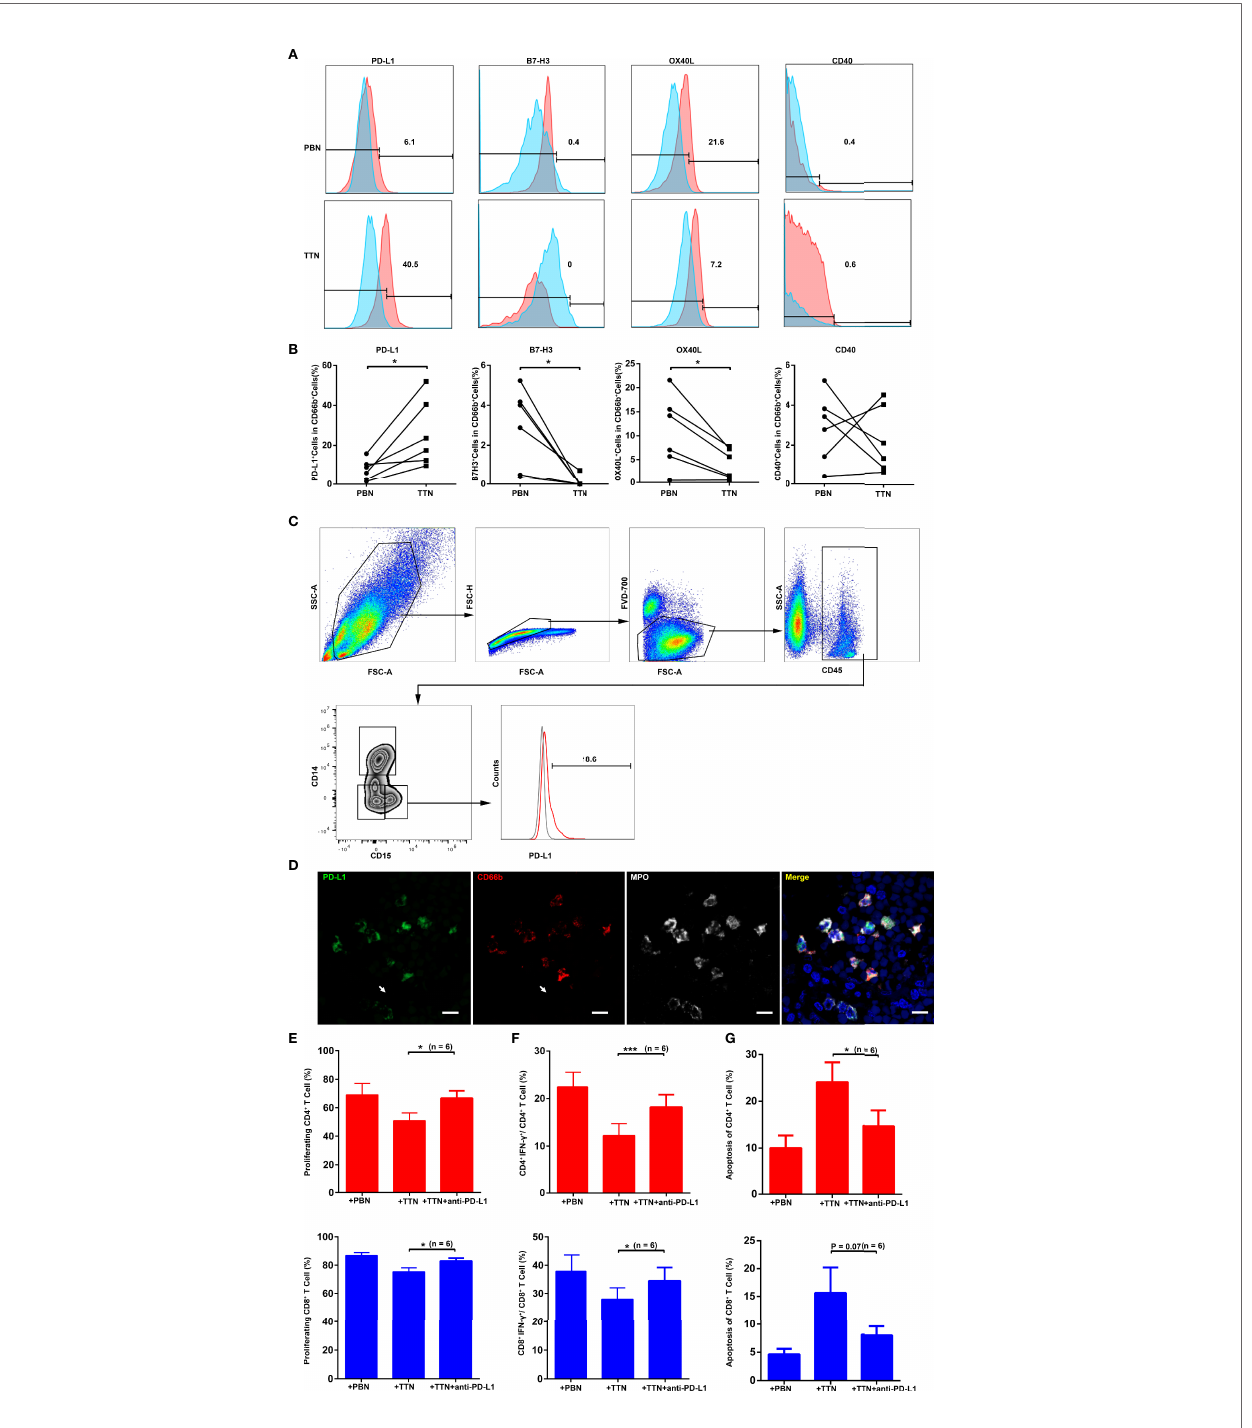
FIGURE 4 | The expression of PD-L1 on TTN and its role in the suppression of T cell immunity. (A) The expression of co-suppressive molecules (PD-L1 and B7-H3) and co-stimulatory molecules (OX40L and CD40) were analyzed by fl ow cytometry on gated live CD11b + CD66b + PBNs (top) and tumor cell line T24 supernatant- treated PBNs (TTNs, bottom). Results from one out of six representative experiments are shown. (B) The panel summarizes the change in the percentage of the indicated markers on autologous PBNs and TTNs. (C) The expression of PD-L1 were analyzed by fl ow cytometry on gated CD45 + CD15 + TANs in human fresh UCB tissues. (Gray: Isotype; Red: TANs). (D) Representative pictures showing the co-expression of PD-L1 with CD66b and MPO on tumor-in fi ltrating neutrophils in UCB tissues. (E – G) The ef fi cacy of a PD-L1 blocking Ab in ablating the effect of TTNs on T cell proliferation (E) , IFN- g production (F) and apoptosis (G) . Data shown are from six independent experiments in E – G , respectively. Error bars represent the mean ± SEM. P < 0.05 was considered a signi fi cant difference (Student ’ s t- test, paired parametric test). * P < 0.05; *** P <